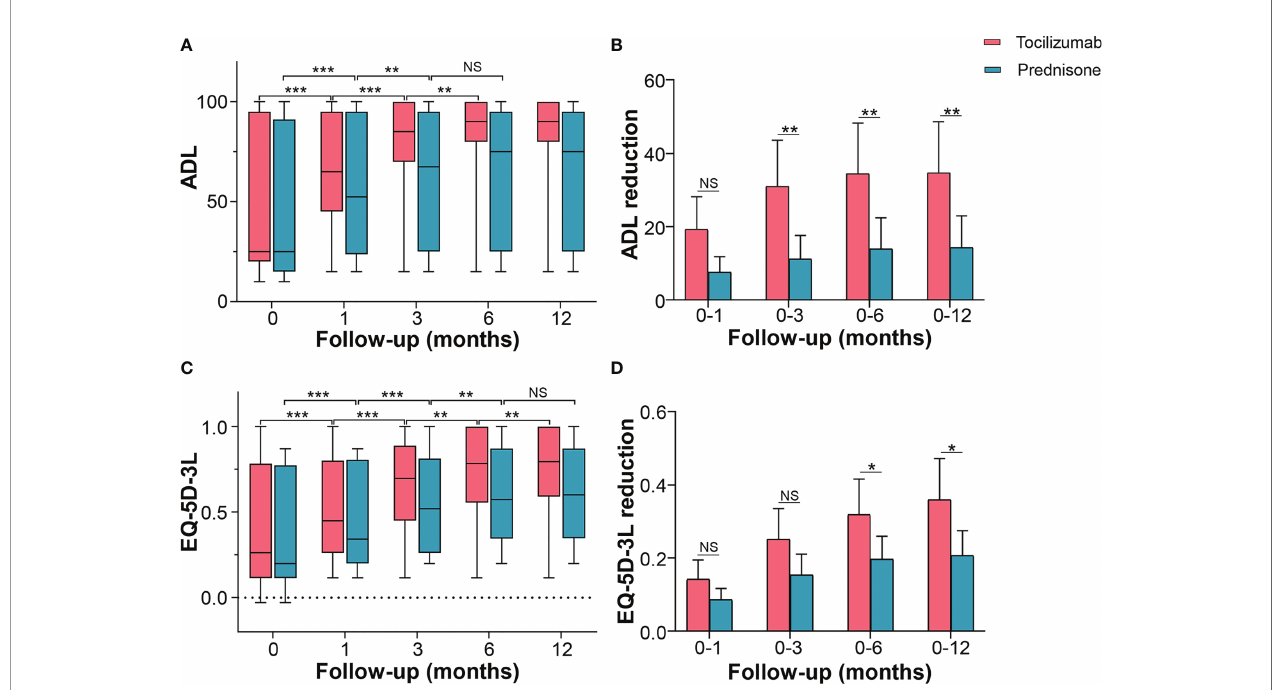
FIGURE 4 | Effects of tocilizumab and prednisone on quality of life. (A) Changes of ADL score at baseline, 1 month, 3 months, 6 months, and 12 months in patients receiving tocilizumab and prednisone. (B) Comparisons of ADL improvements between the two groups. (C) Changes in EQ-5D-3L score at baseline, 1 month, 3 months, 6 months, and 12 months in patients receiving tocilizumab and prednisone. (D) Comparisons of EQ-5D-3L improvements between the two groups. ADL: activity of daily living; EQ-5D-3L: EuroQol Five-dimensions Three-level questionnaire. * p < 0.05; ** p < 0.01; *** p < 0.001; NS, not signi fi